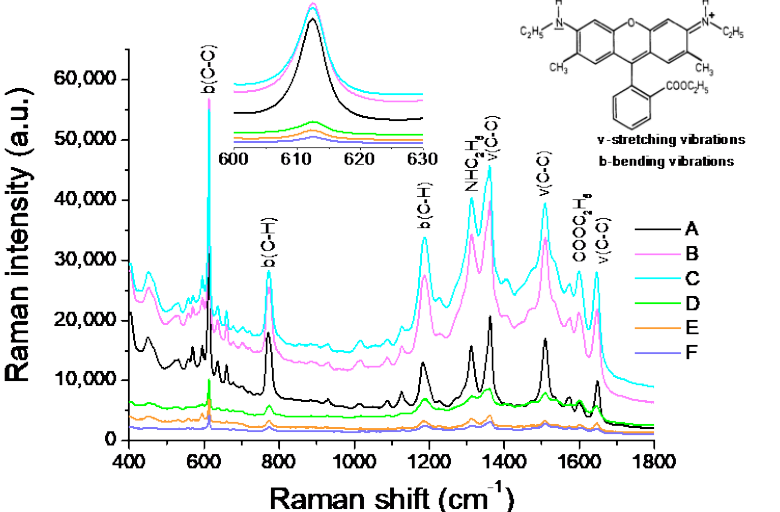
Figure 7. The SERS spectra resulting from the R6G analyte (10 − 6 M) by the silver layers of the various relative thicknesses. Table 6. The S/B ratios of Samples A–F. Sample